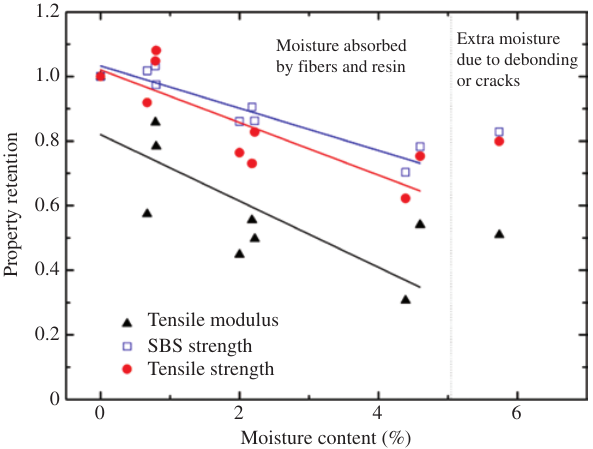
Figure 9 Variation of the tensile strength, modulus and short beam shear strength of ramie fiber fabric reinforced phenolic resin as a function of moisture